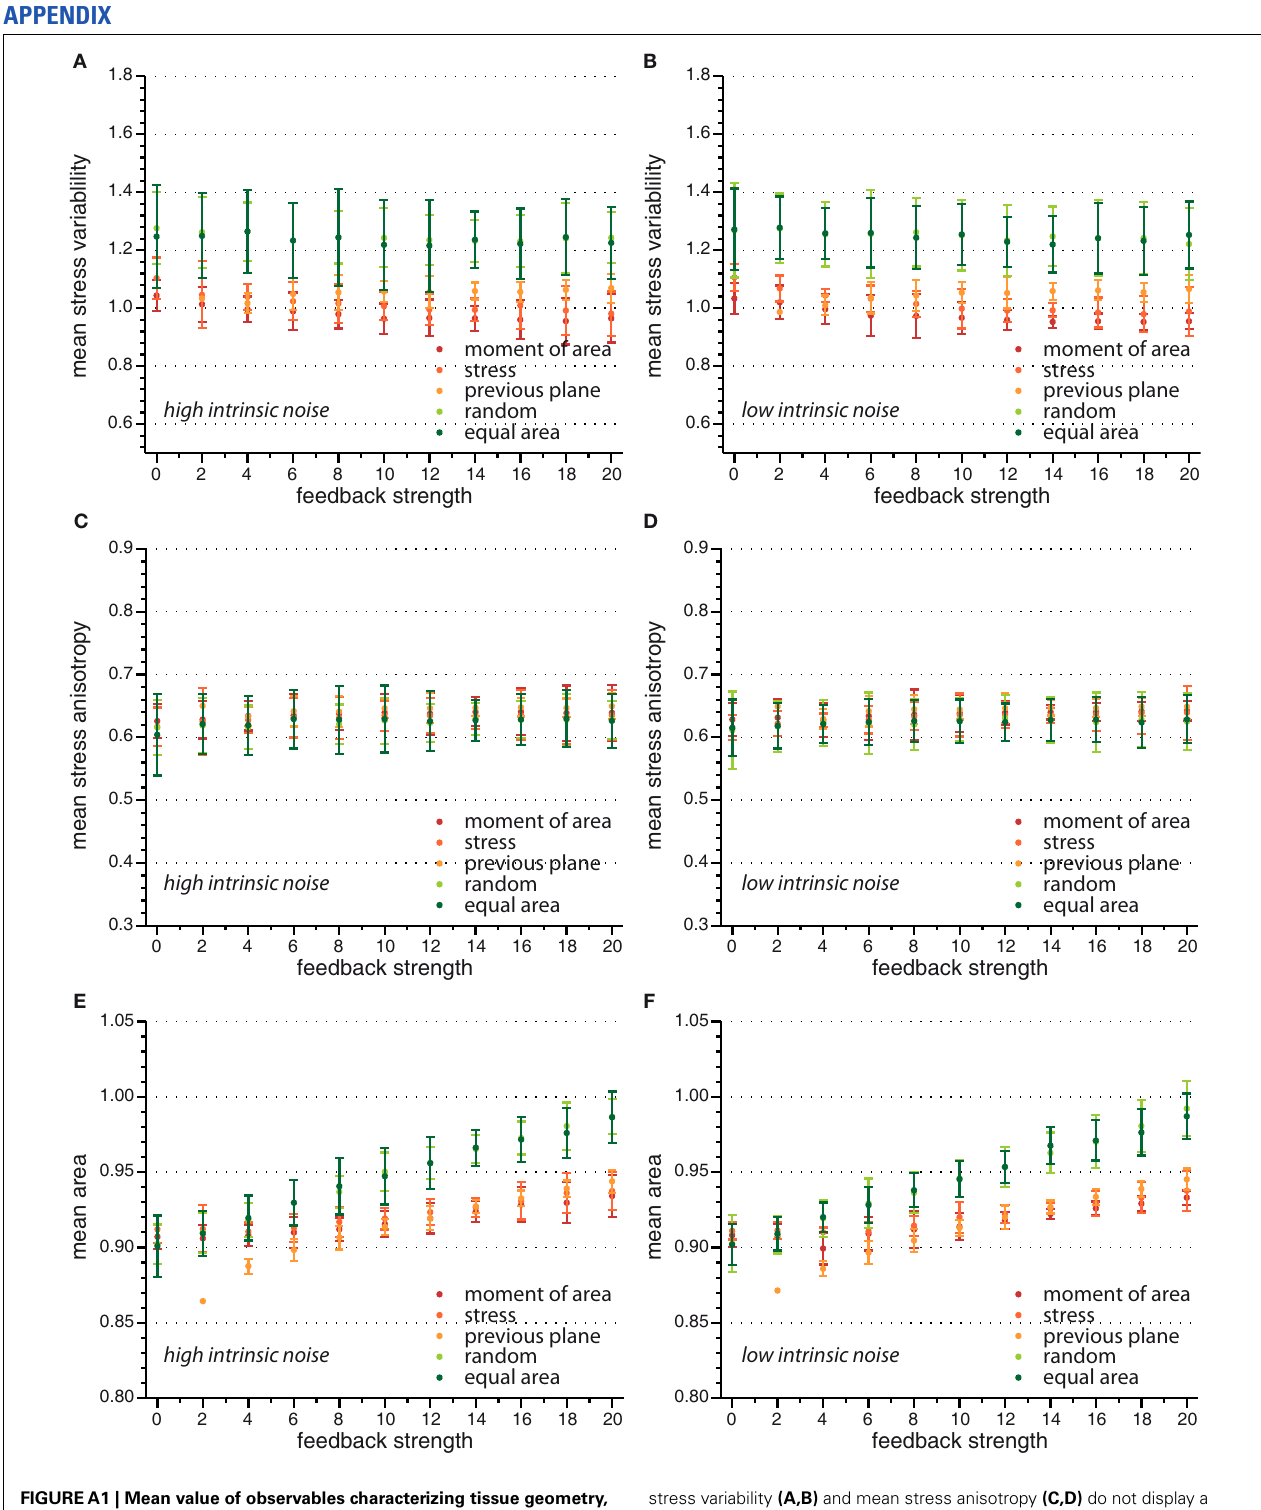
FIGUREA1 | Mean value of observables characterizing tissue geometry, topology, and stress distribution for the different cell division modes versus feedback strength for high and low intrinsic noise. While mean